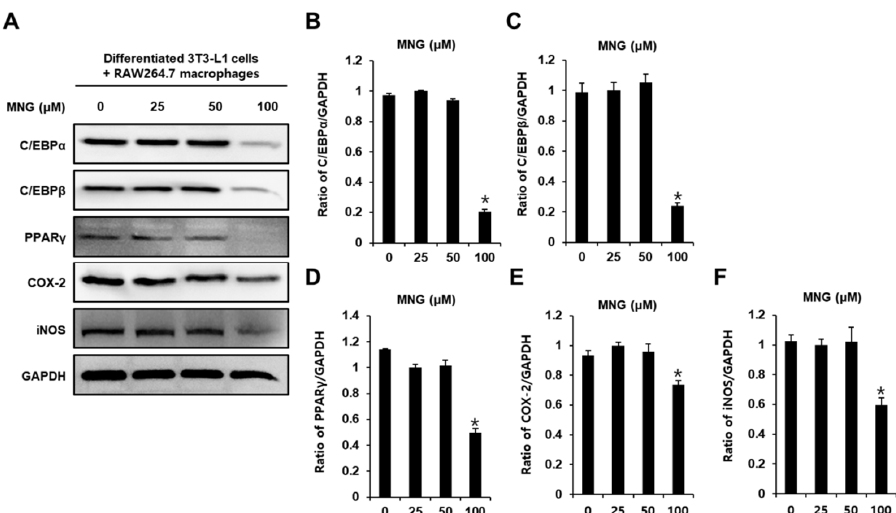
Figure 4. Inhibitory effects of MNG on adipogenesis ‐ and inflammation ‐ associated proteins in co ‐ culture condition with 3T3 ‐ L1 and RAW264.7 cells. ( A ) Protein expression of CCAAT/enhancer ‐ binding protein alpha (C/EBP α ), C/EBP β , peroxisome proliferator ‐ activated receptor γ (PPAR γ ), cyclooxygenase 2 (COX ‐ 2), and inducible nitric oxide synthase (iNOS) in co ‐ culture condition with 3T3 ‐ L1 and RAW264.7 cells treated with the indicated concentration of MNG. ( B – F ) Analysis of ratios of band intensities of C/EBP α , C/EBP β , PPAR γ , COX ‐ 2, and iNOS. ( n = 3 independent experiments, * p < 0.05, Kruskal–Wallis nonparametric test). Data represent the mean ± SEM.